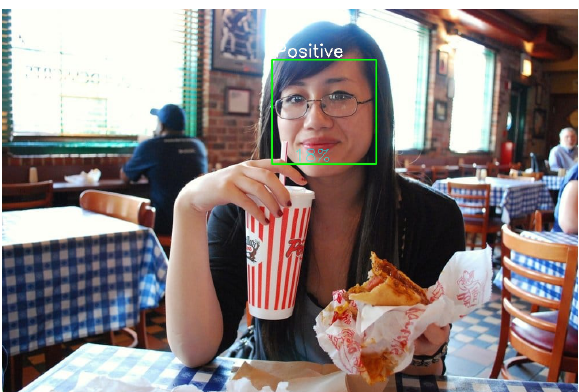
Fig.6. Code to categorize images as positive,negative,neutral The figure above(Fig.6.) represents the code to cat-